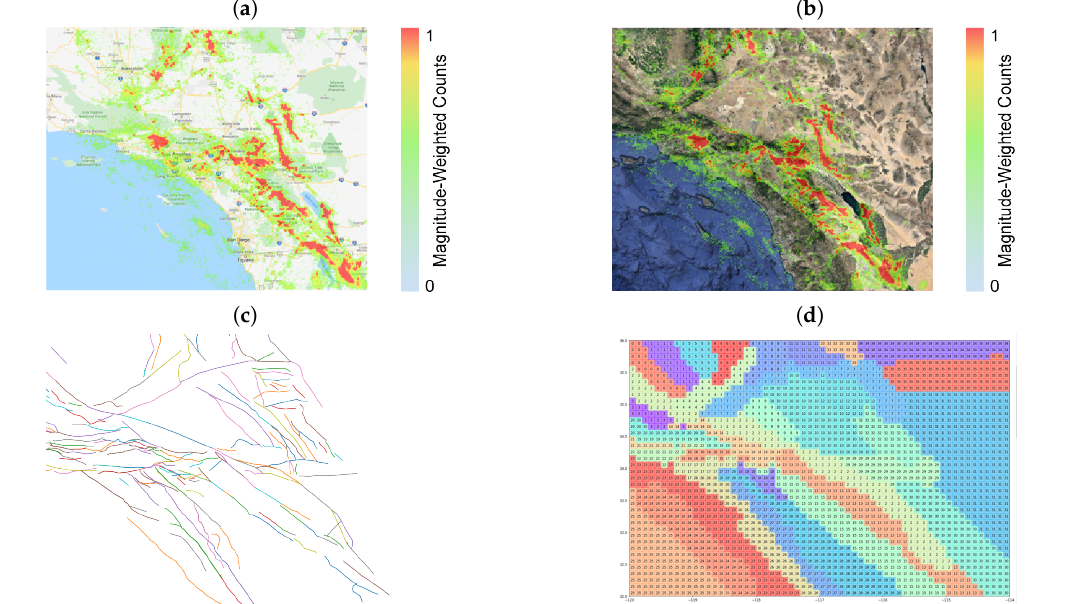
Figure 7. Region studied showing earthquake activity ( a , b ); raw faults in ( c ); and grouped fault regions in ( d ). ( a ) Region studied as a standard map; the redder regions represent earthquakes of higher magnitude. ( b ) Region studied on a satellite map; the redder regions represent earthquakes of higher magnitude. ( c ) Fault lines [41] grouped together in ( d ). ( d ) Fault regions [41] after fault grouping together with a particular space-filling label for each of the 2400